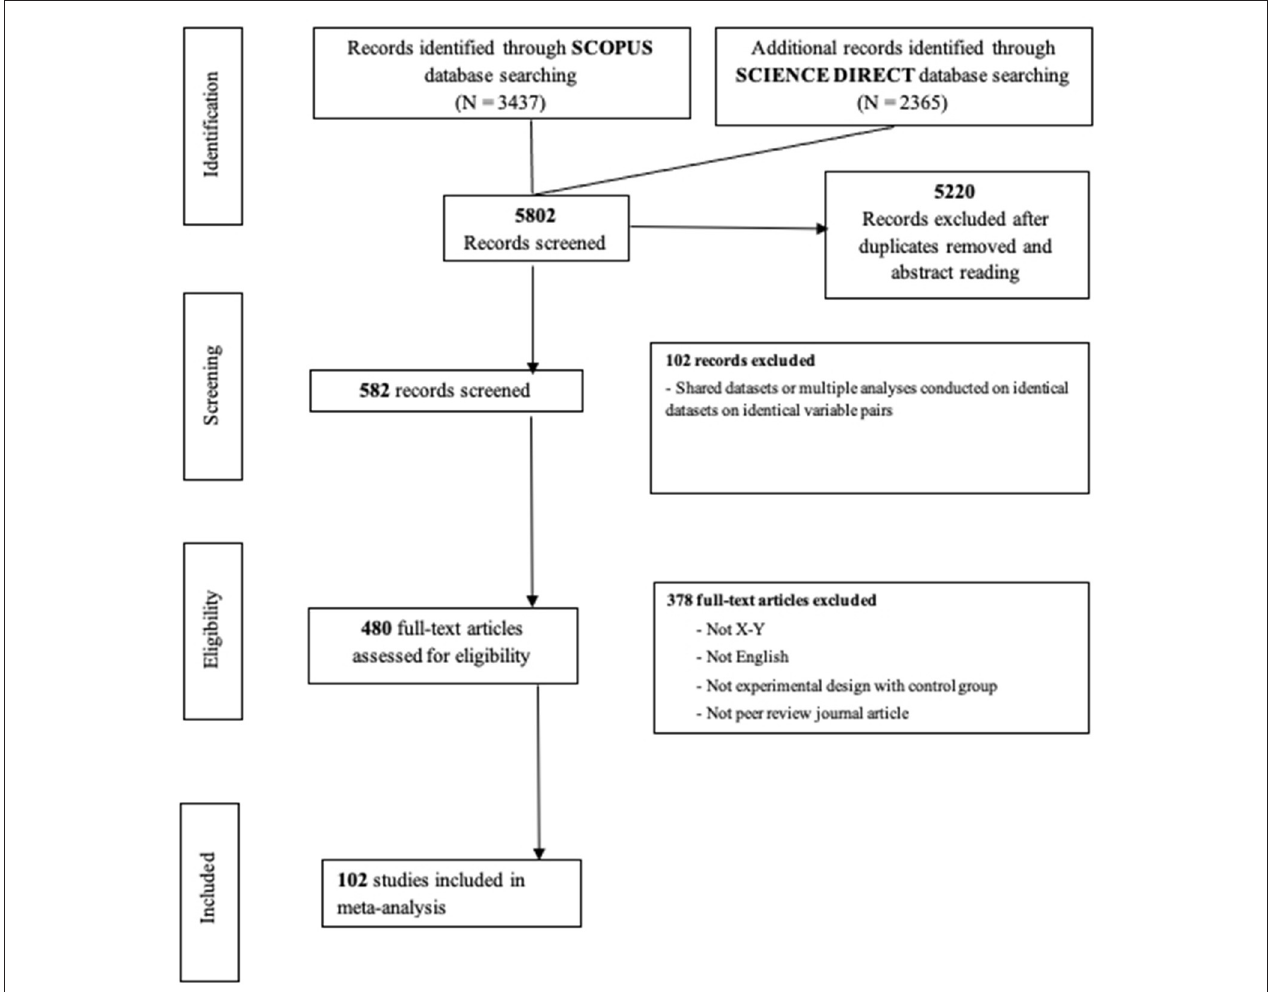
FIGURE 1 | PRISMA diagram describing the article selection